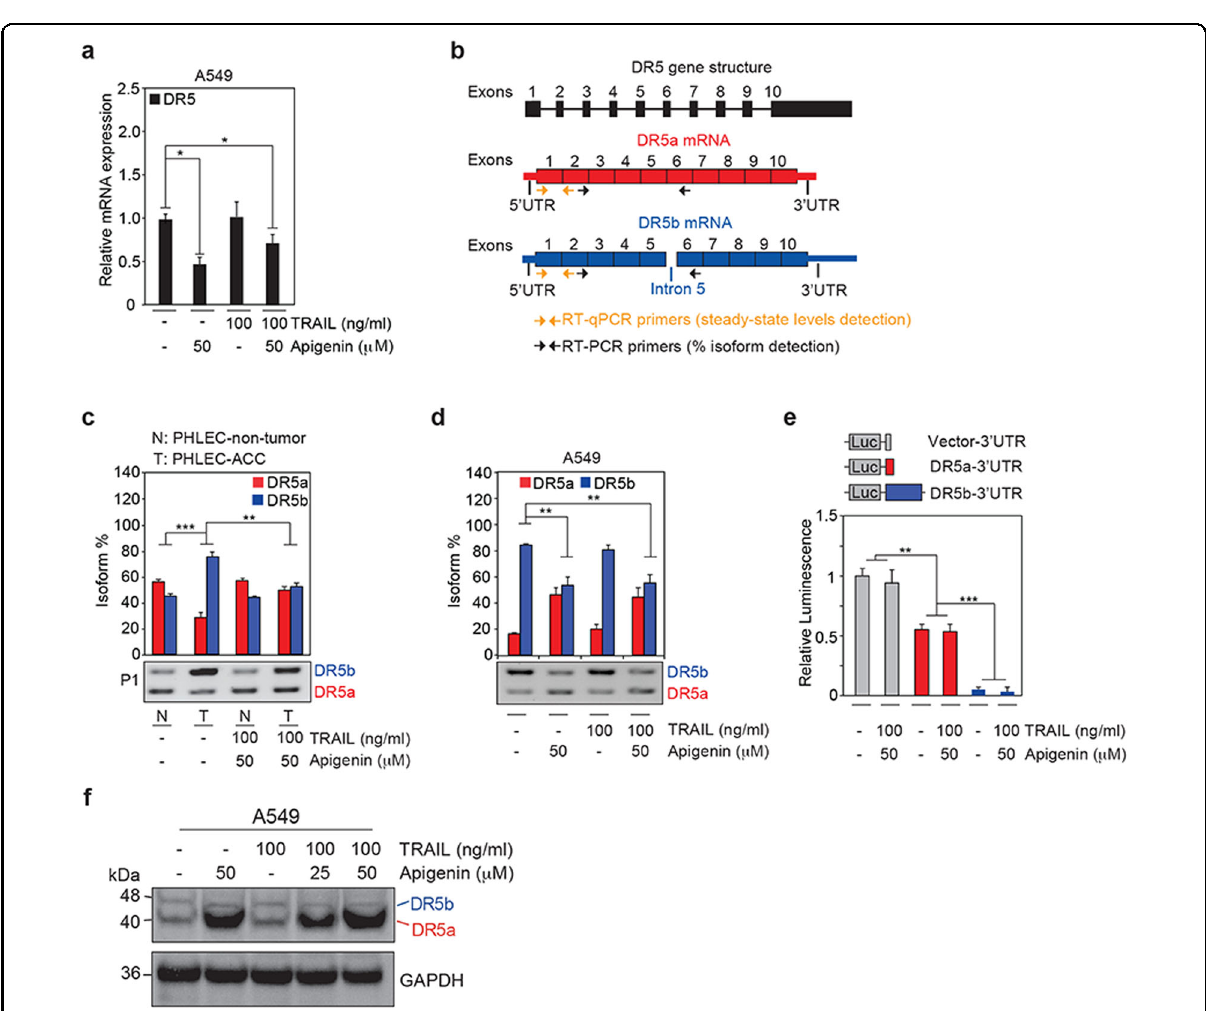
Fig. 3 Apigenin modulates alternative splicing of DR5 and c-FLIP isoforms. a A549 NSCLC cells were pretreated with 50 μ M apigenin or DMSO (-) for 18 h followed by treatment with 100 ng/ml TRAIL for 6 h; then, the relative steady-state mRNA expression of DR5 was assessed by RT-qPCR using primers indicated by the orange arrows in ( b ). b Schematics of the DR5 gene structure including introns represented by a line and exons represented by fi lled numbered boxes. There are two annotated protein-coding DR5 transcripts, DR5a (ENST00000347739.3) and DR5b (ENST00000276431.9). The splice isoforms of DR5 mRNA, DR5a (in red), and DR5b (blue) with UTRs represented by thinner fi lled boxes. These two isoforms were ampli fi ed by RT-PCR using the same set of primers, indicated by the black arrows, and separated using agarose gel electrophoresis. The amplicon of DR5b , which contains intron 5 (lighter blue), is 84 bp larger than the amplicon of DR5a . c PHLECs isolated from paired nontumor (N) and adenocarcinoma tumor (T) biopsies from human patients (P1 – P3) were pretreated for 18 h with 50 μ M apigenin or DMSO (-) followed by treatment with 100 ng/ml TRAIL for 6 h; controls were treated only with DMSO (-); then, the alternative splicing of DR5a and DR5b was determined by RT-PCR using isoform-speci fi c primers (indicated by the black arrows in [ b ]). Quanti fi cation of the isoforms observed in the gels was done by densitometry. The percent of each isoform was calculated as follows: (density of one isoform)/(density of the sum of the two isoforms) × 100. Bar plots summarize the quantitation and represent the mean ± SEM ( n = 3). The picture in the bottom is a representative image of an agarose gel depicting the DR5a and DR5b isoforms obtained by RT-PCR and separated by gel electrophoresis. d The percentages of DR5b and DR5a isoforms in the same samples used in ( a ) were determined by RT-PCR using isoform-speci fi c primers (indicated by the black arrows in [ b ]). Quanti fi cation of the isoforms observed in the gels was done by densitometry as indicated in ( c ). The picture in the bottom is a representative image of an agarose gel depicting the DR5a and DR5b isoforms obtained by RT-PCR and separated by gel electrophoresis. Bar plots summarize the quantitation and represent the mean ± SEM ( n = 4). e A549 cells transiently transfected with luciferase-tagged DR5a -3 ′ UTR, DR5b -3 ′ UTR, or luciferase control vector were pretreated for 18 h with apigenin or DMSO and then with 100 ng/ml TRAIL for 6 h, and the relative luminescence activity was measured. Cotransfection with the pCMV- β -Gal plasmid was used for normalization by the corresponding β -Gal activity. f Protein levels of the DR5a (40 kDa) and DR5b (48 kDa) isoforms were assessed by western blot in A549 cells using an anti-DR5 antibody from ProScience. The picture is a representative of three independent experiments. Data are expressed as the mean ± SEM (Fig. 3a and d, n = 4; Fig. 3c and e, n = 3; * P < 0.05, ** P < 0.01, and *** P < 0.001; and analyses were performed by two-way ANOVA followed by Tukey ’ s post hoc